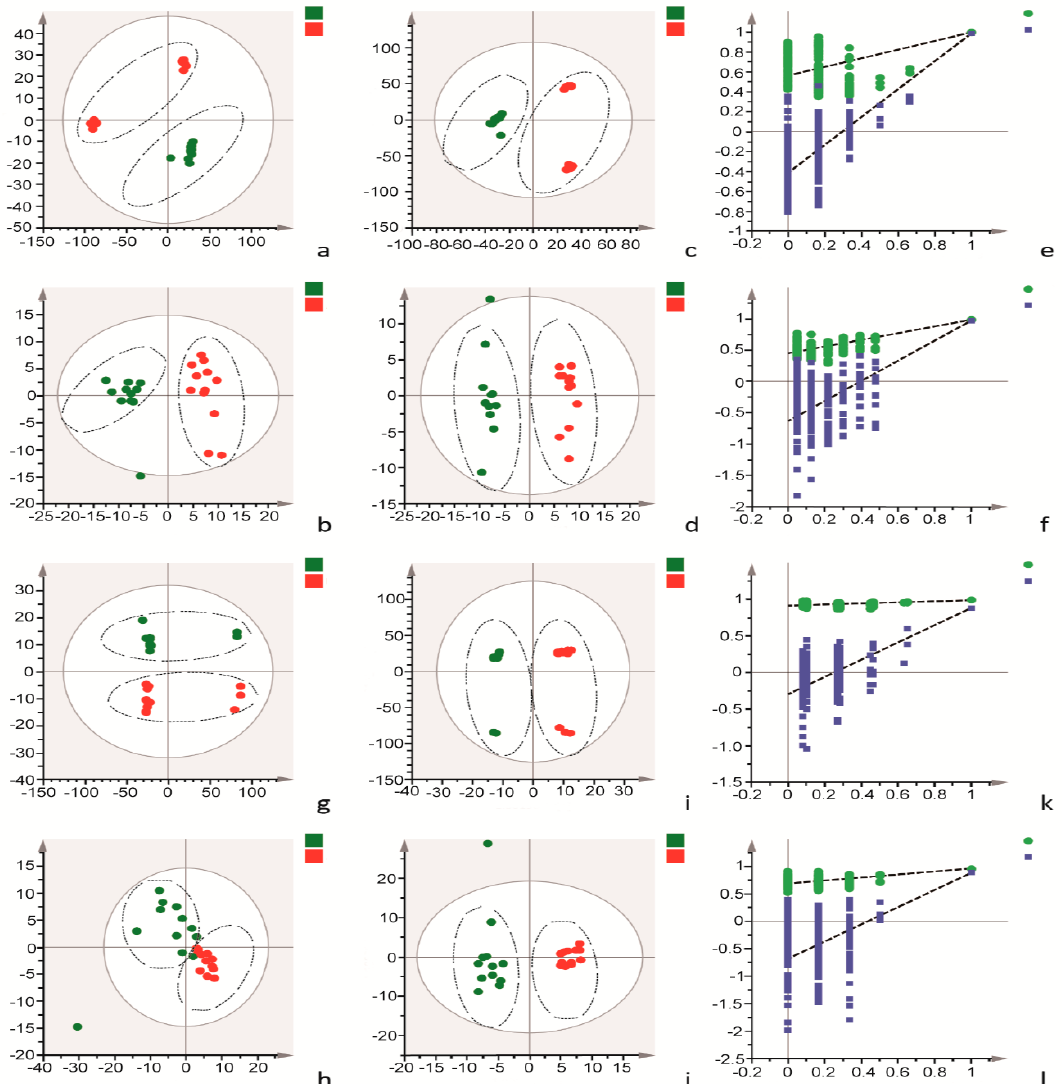
Figure 4. Multivariate analyses data from the UPLC-Q-TOF / MS analysis of cells and cell culture supernatants in the absence of H 2 O 2 . ( a , b ): PCA score plots based on cell culture supernatant metabolic profiles of the normal and AEE groups in positive and negative modes, ESI + : R 2 = 0.773, ESI − : R 2 = 0.602. ( c , d ): OPLS-DA score plots of normal and AEE groups in positive and negative modes, ESI + : R 2 X = 0.773, R 2 Y = 0.993, Q 2 = 0.982; ESI − : R 2 X = 0.442, R 2 Y = 0.985, Q 2 = 0.971. ( e , f ): Permutation test of the OPLS-DA model, ESI + : the intercepts of R 2 = 0.512 and Q 2 = − 0.424, ESI − : the intercepts of R 2 = 0.469 and Q 2 = − 0.615. ( g , h ): PCA score plots based on cellular metabolic profiles of the normal and AEE groups in positive and negative modes, ESI + : R 2 = 0.778, ESI − : R 2 = 0.643. ( i , j ): OPLS-DA score plots of the normal and AEE groups in positive and negative modes, ESI + : R 2 X = 0.795, R 2 Y = 0.99, Q 2 = 0.886; ESI − : R 2 X = 0.542, R 2 Y = 0.965, Q 2 = 0.885. ( k , l ): Permutation test of the OPLS-DA model, ESI + : the intercepts of R 2 = 0.923 and Q 2 = − 0.225, ESI − : the intercepts of R 2 = 0.696 and Q 2 = − 0.72. Z: normal group; B: AEE group.